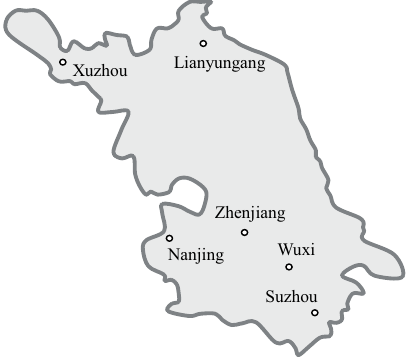
Fig. 1. Geographical position of six administrative regions in Jiangsu